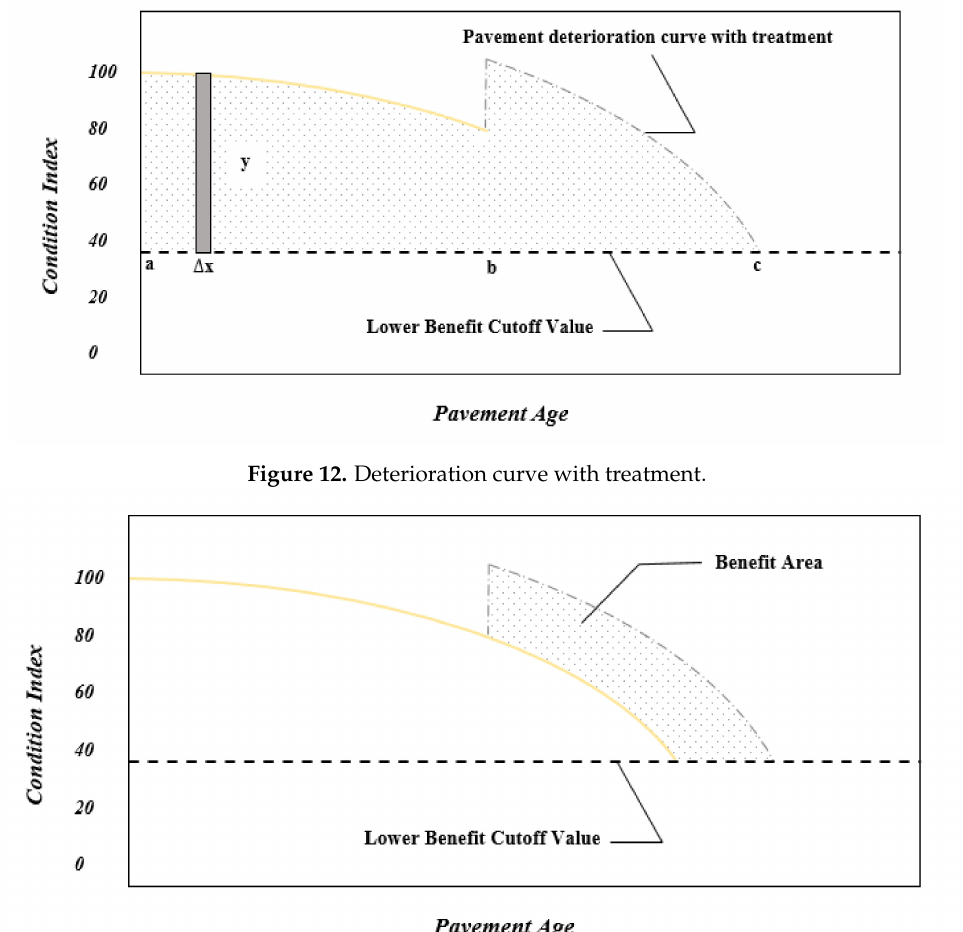
Figure 13. Total benefit